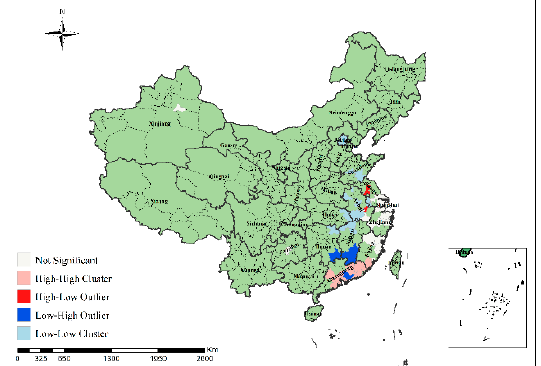
Figure 9. Local spatial autocorrelation analysis results of H7N9 outbreaks in China in 2015.